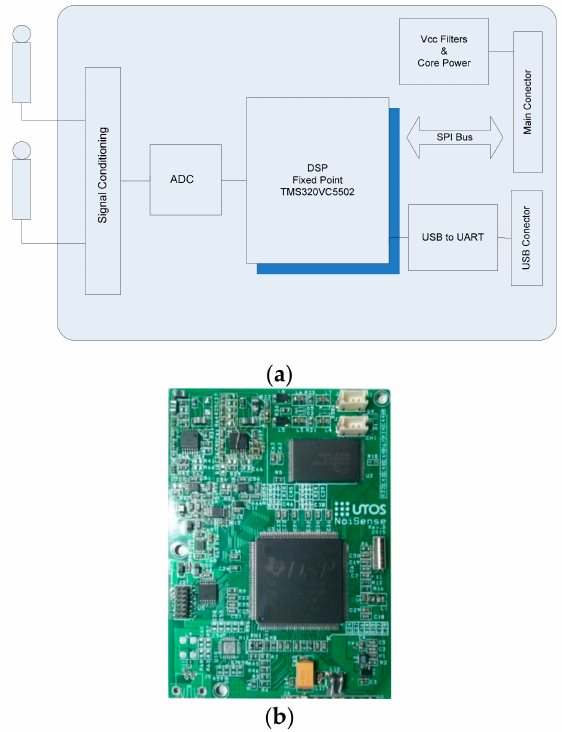
Figure 1. ( a ) Block diagram of the original equipment manufacturer (OEM) module for noise measurement; ( b ) final circuit implementation of 87 × 62 mm. DSP = digital signal processor; SPI bus = serial peripheral interface; ADC = analog to digital converter; UART = universal asynchronous